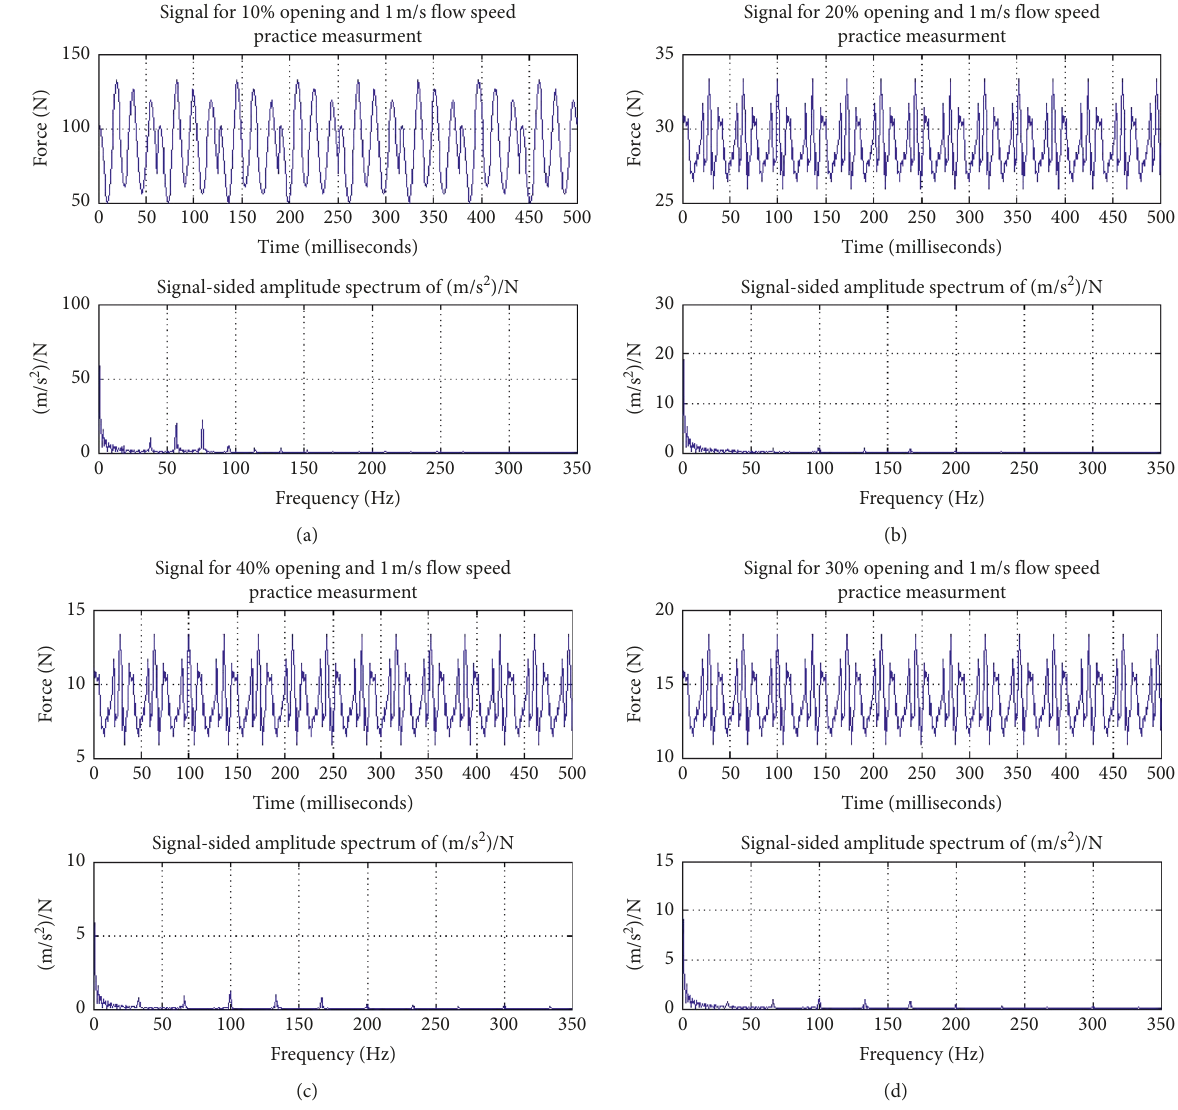
Figure 17: Lift force acting on flat face plug with flow velocity 1m/s and different valve opening. (a) 10% valve opening; (b) 20% valve opening; (c) 30% valve opening; (d) 40% valve